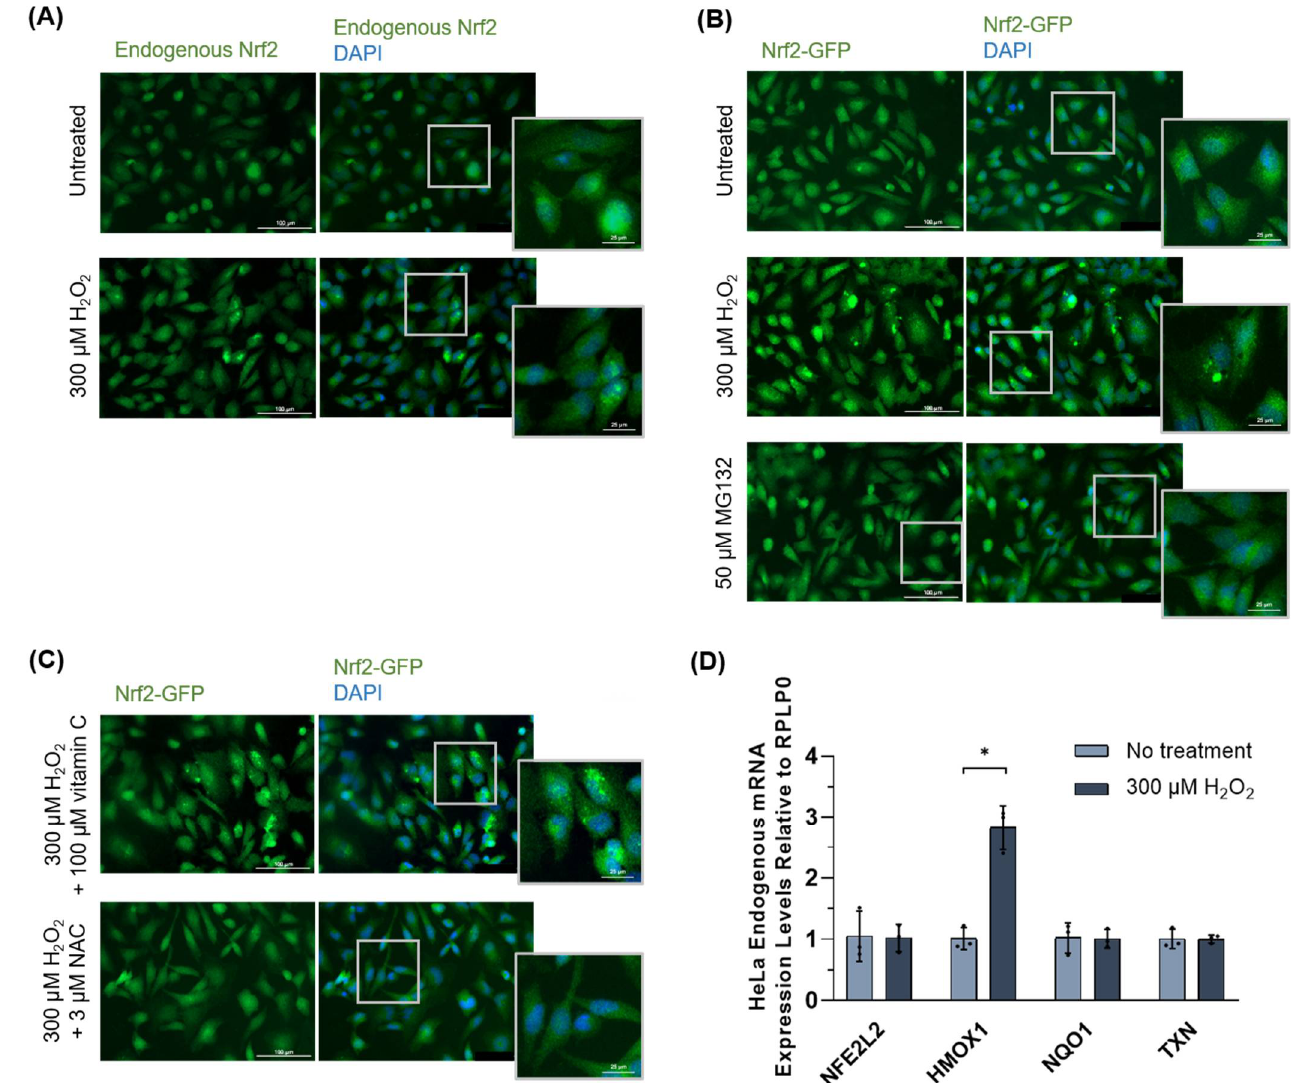
Figure 4. Further analyses of the oxidative stress-induced protein misfolding of Nrf2. ( A ) Endogenous Nrf2 in un-transfected HeLa cells treated with 300 µM H 2 O 2 for 3 h, visualized by immunofluorescence microscopy. ( B ) Transfected Nrf2-GFP in HeLa cells treated with 50 µM MG132 for 6 h, visualized by fluorescence microscopy. ( C ) Transfected Keap1-GFP in HeLa cells pretreated with 100 µM vitamin C or 3 µM NAC for 24 h followed by treatment with 300 µM H 2 O 2 for 3 h, visualized by fluorescence microscopy. ( D ) Relative mRNA levels of Nrf2 ( NFE2L2 ), Nrf2 target genes ( HMOX1 , NQO1 ), and thioredoxin ( TXN ) were evaluated by RT-qPCR following treatment of HeLa cells with 300 µM H 2 O 2 for 3 h. Data were normalized to RPLP0 transcript levels. Means derived from three replicates were used during analysis. Data are expressed as mean ± SD. p < 0.05 was considered statistically significant; * p < 0.05.